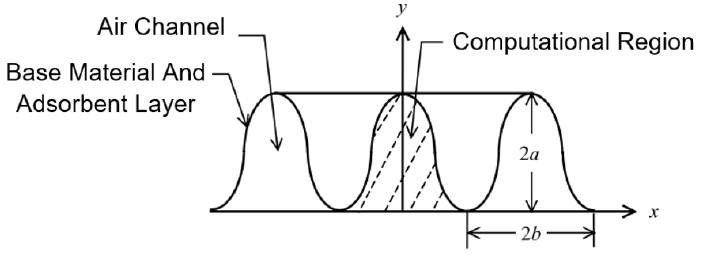
Figure 3. Corrugated air passage.